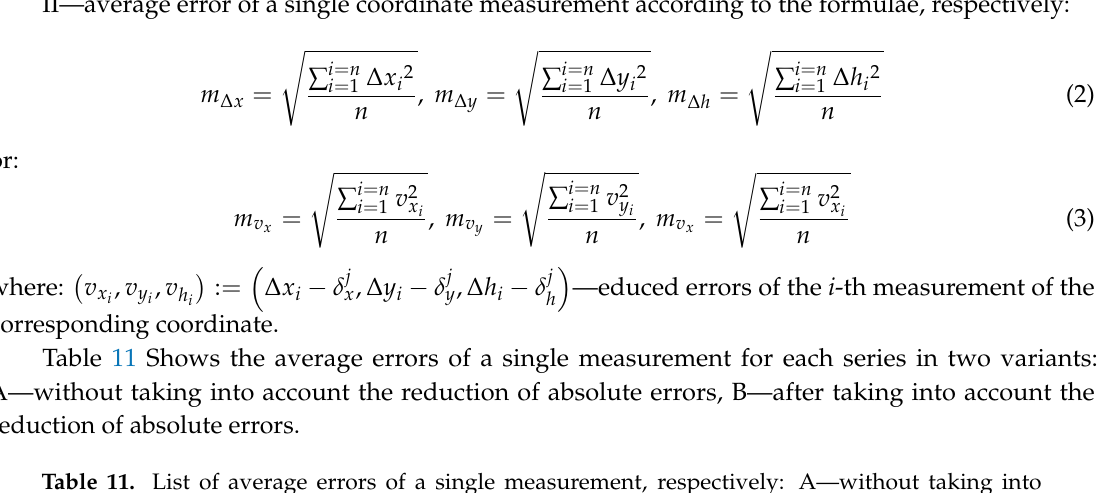
Table 11. List of average errors of a single measurement, respectively: A—without taking into account the reduction of absolute errors, B—after taking into account the reduction of absolute errors